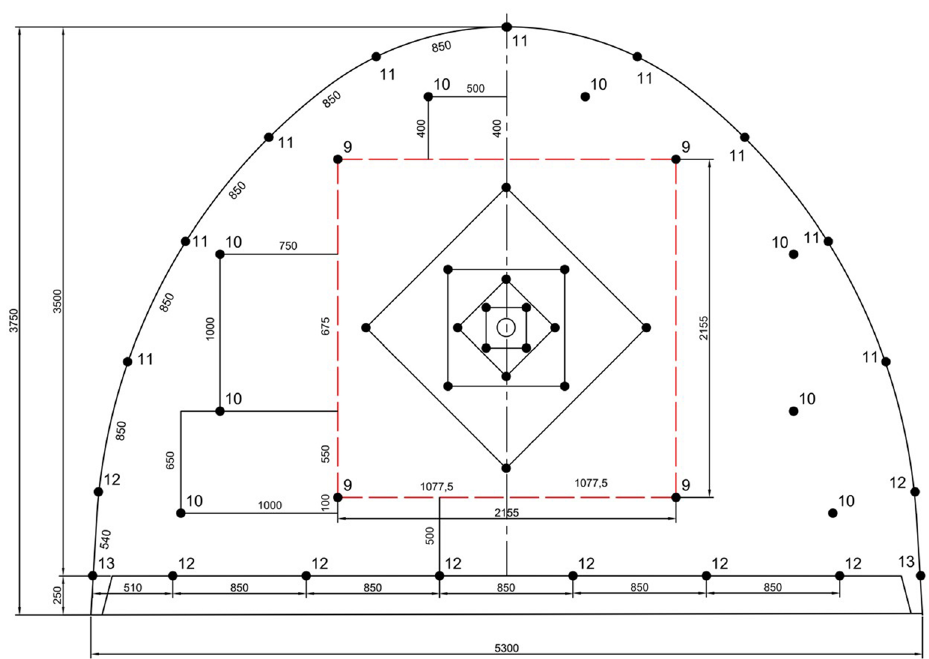
Figure 11. The arrangement of blastholes and firing sequences in excavation of 14 m 2 cross-section development roadway for 115 mm empty hole diameter (see Fig. 9 for cut